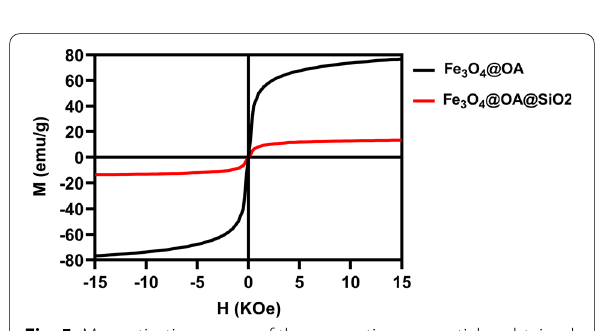
Fig. 5 Magnetization curves of the magnetic nanoparticles obtained by vibrating sample magnetometer at room temperature